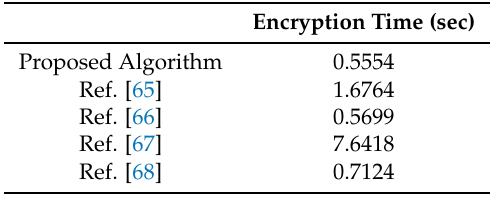
Table 6. Encryption time and comparisons (256 × 256